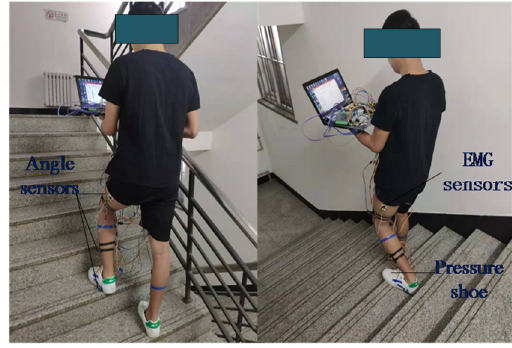
Figure 5. Data acquisition process.